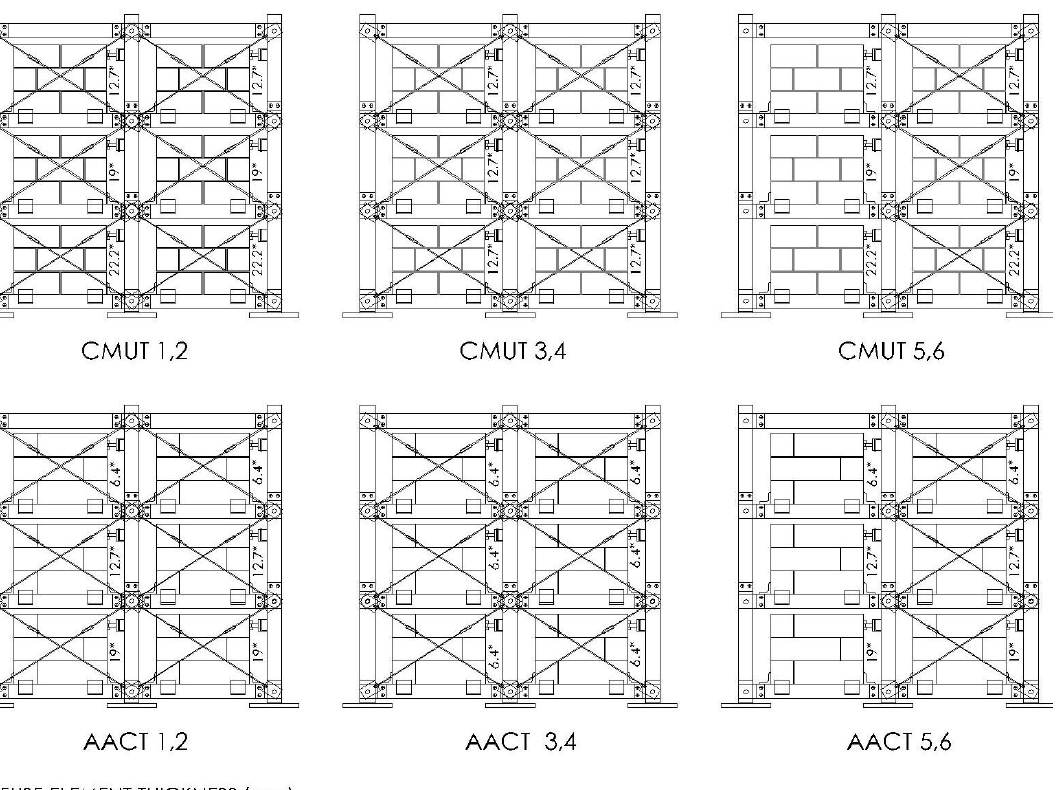
Figure 8. Test frame configurations for parametric testing